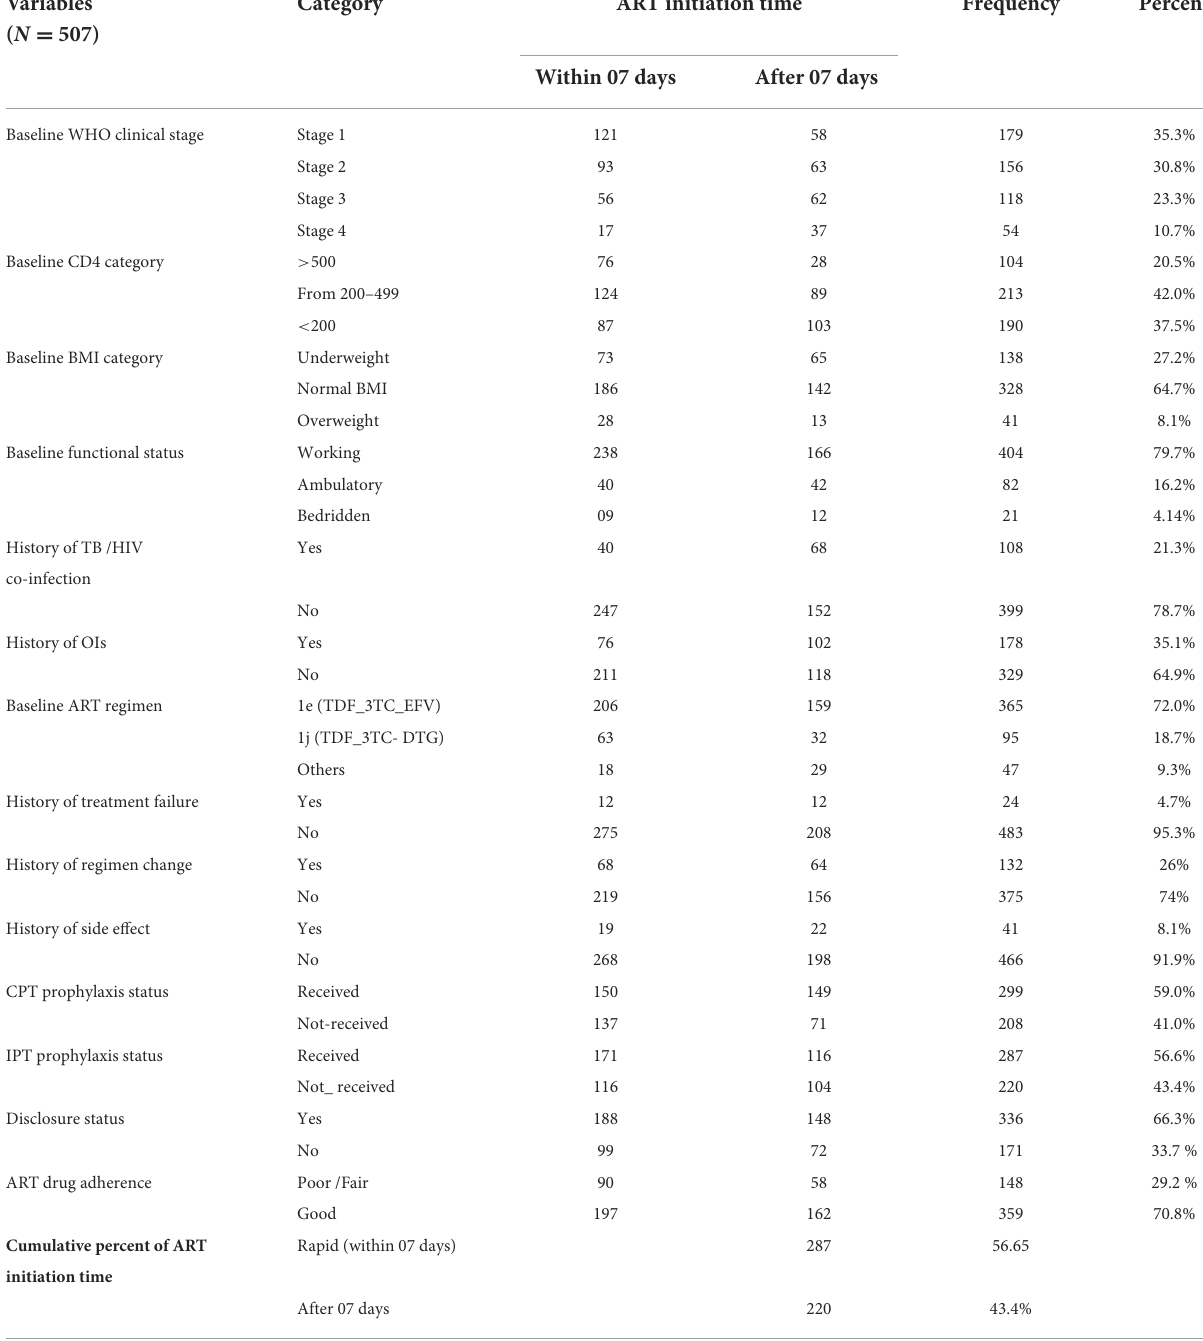
TABLE 2 Clinical and treatment-related characteristics of adults receiving ART by Art initiation time in FHCSH, Northwest Ethiopia, 2022.